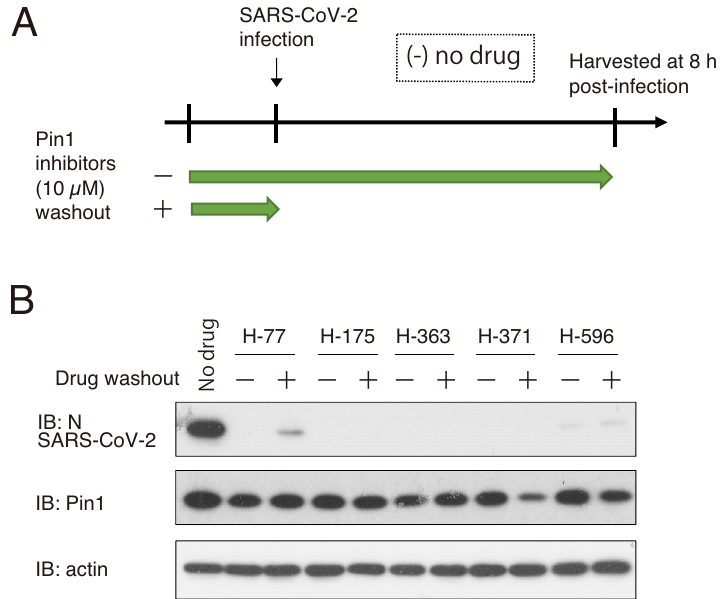
Figure 4. Inhibition of SARS-CoV-2 proliferation by Pin1 inhibitors was not abolished upon their removal before SARS-CoV-2 infection. VeroE6/TMPRSS2 cells were pretreated with 10 μM Pin1 inhibitors for 2 h. The Pin1 inhibitors in the medium were either washed out (+) or retained ( −), and then the cells were infected with SARS-CoV-2 at an MOI of 10 followed by incubation for 8 h. ( A ) Schematic diagram showing the incubation period with Pin1 inhibitors. ( B ) Western blotting of cell lysates with SARS-CoV-2N, Pin1, and actin antibodies. Full-length blots are presented in Supplementary Fig. 4.